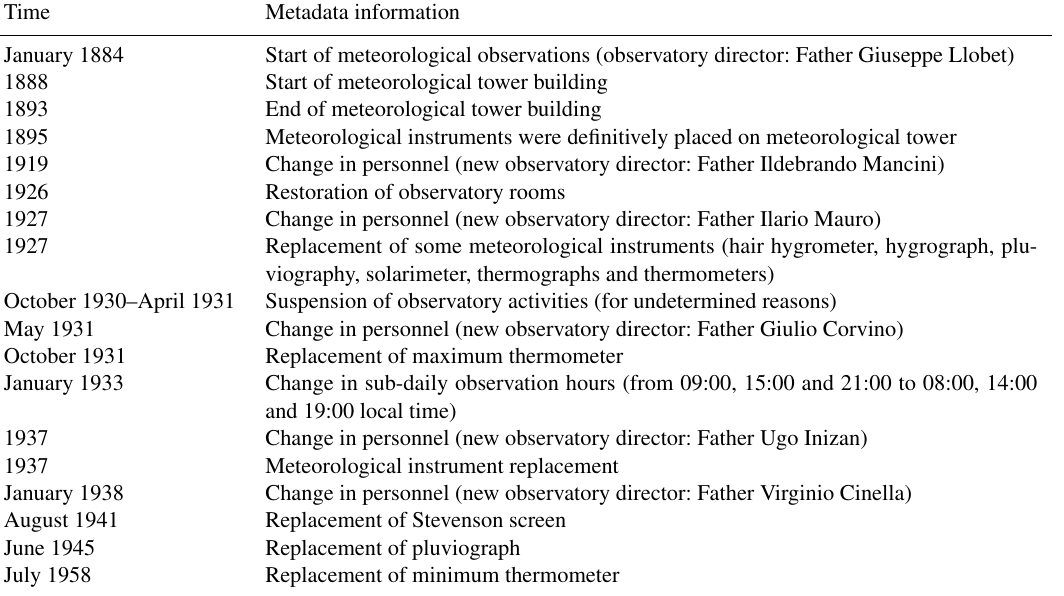
Table 1. Summary of documented metadata in the period from 1884 to 1963. The information about change in instrument relocation and replacement, change in observatory guidance, and site measurement conditions was retrieved from the old Le Cronache dell’Osservatorio diaries and from the meteorological observation